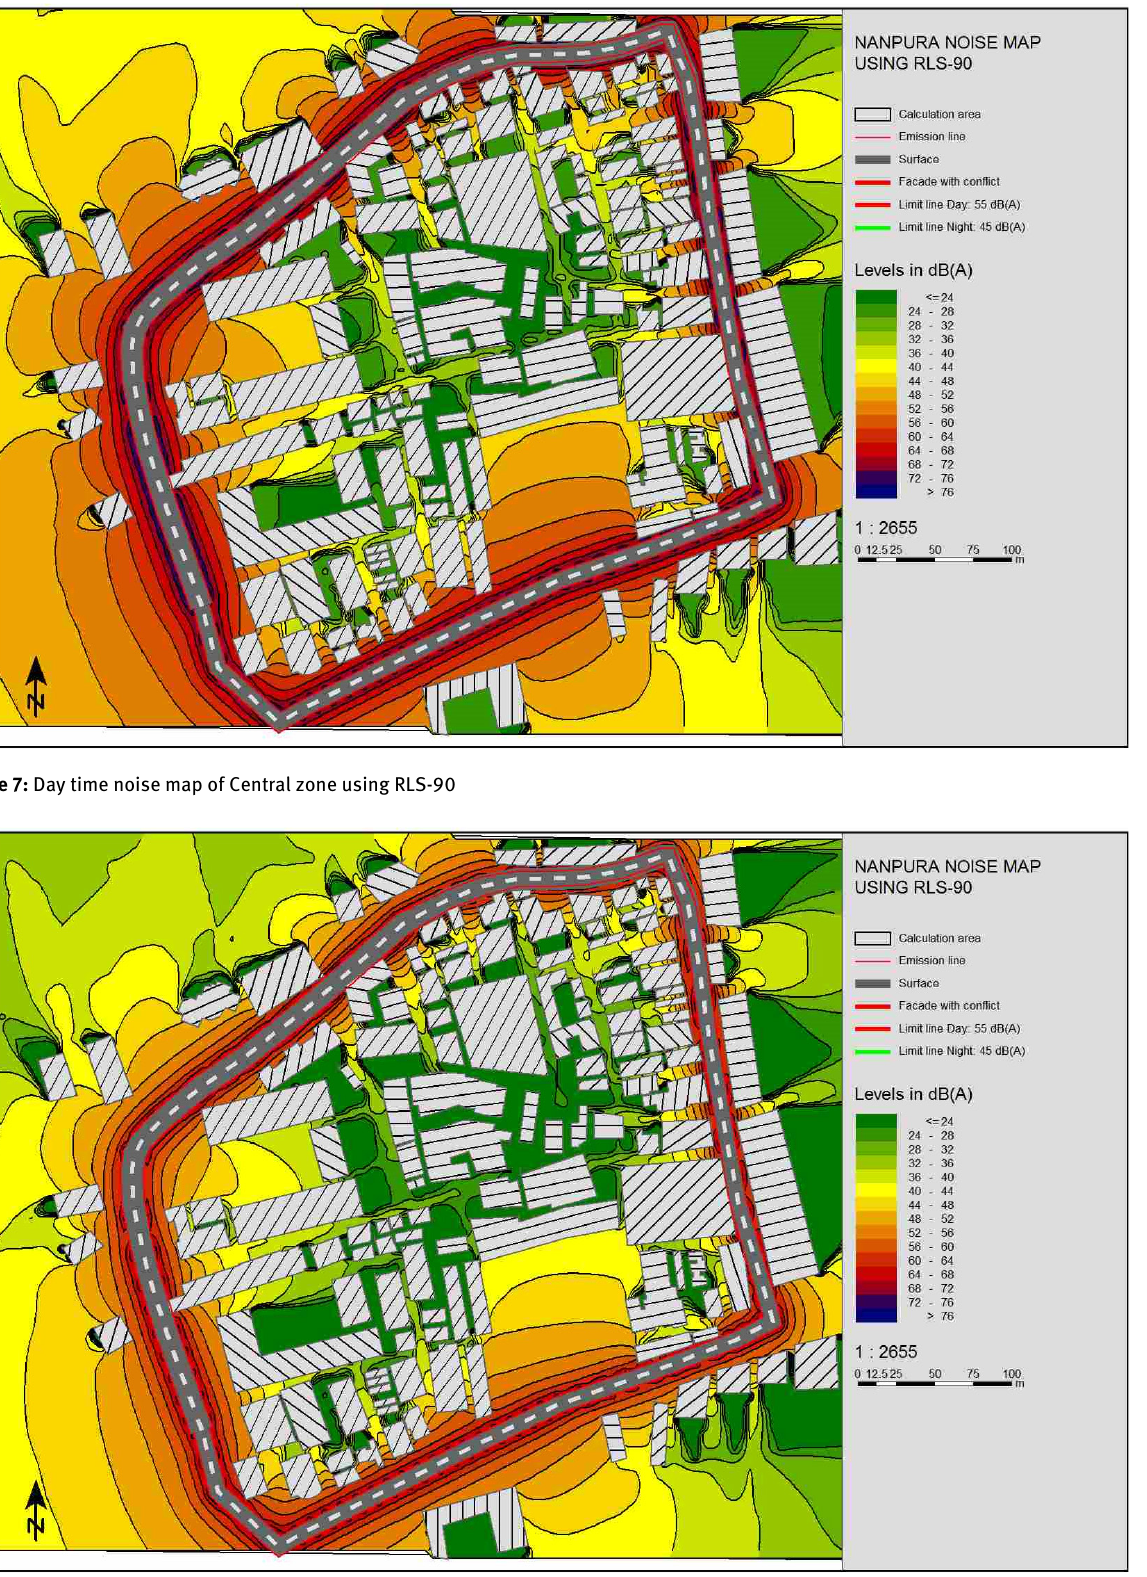
Figure 8: Night time noise map of Central zone using